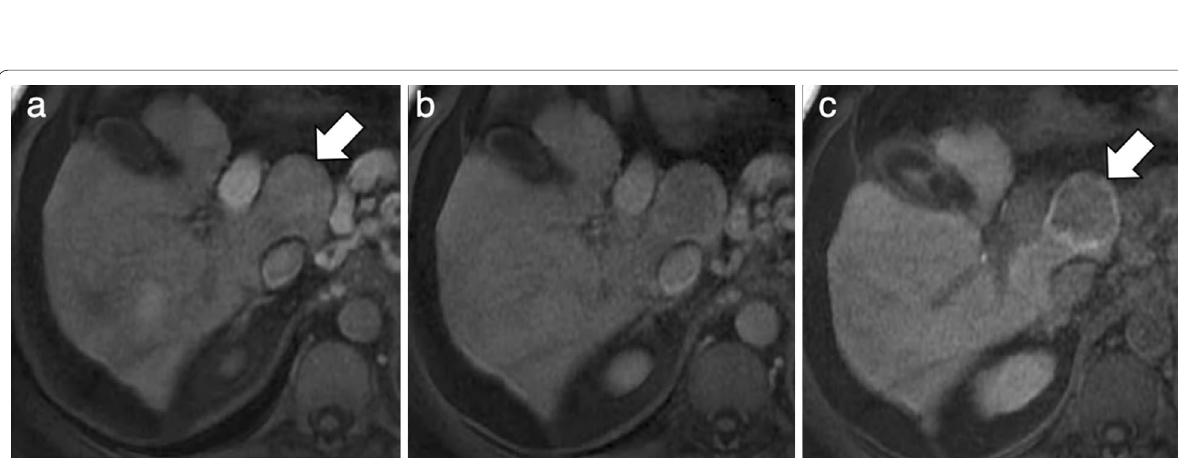
Fig. 14 A 55‑year‑old man with HCV‑related cirrhosis and multiple HCCs. Gadoxetate disodium‑enhanced MRI shows an HCC mass in the caudate lobe with ( a ) arterial phase hyperenhancement in the arterial phase, ( b ) non‑peripheral washout in the portal venous phase and ( c ) hypointensity in the hepatobiliary phase with peripheral hyperintensity (arrow), suggesting microvascular